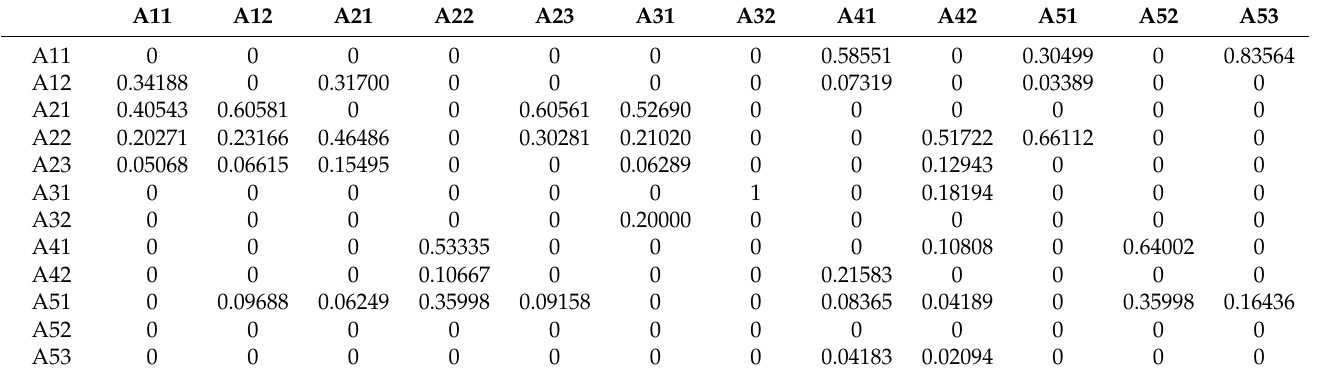
Table 7. The weighted